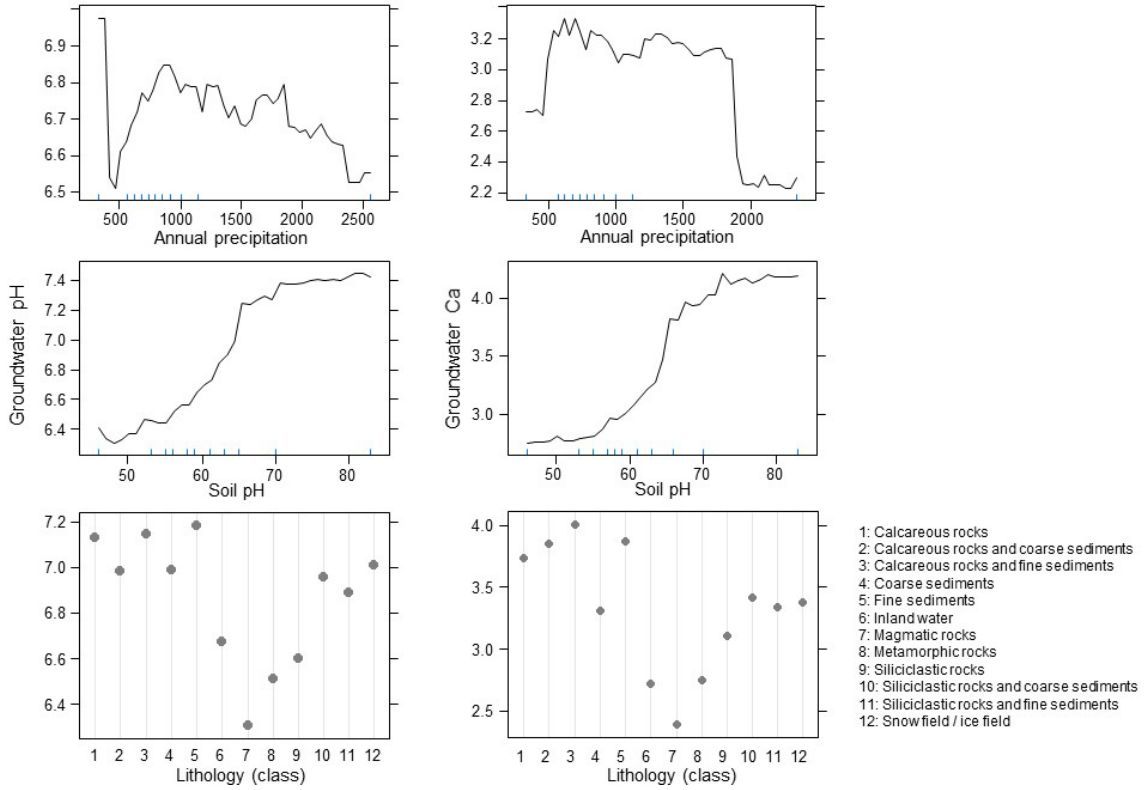
Figure 4. Partial dependence plots showing the effects of the variables used in the random forest models computed for model groundwater pH and Ca 2 + in